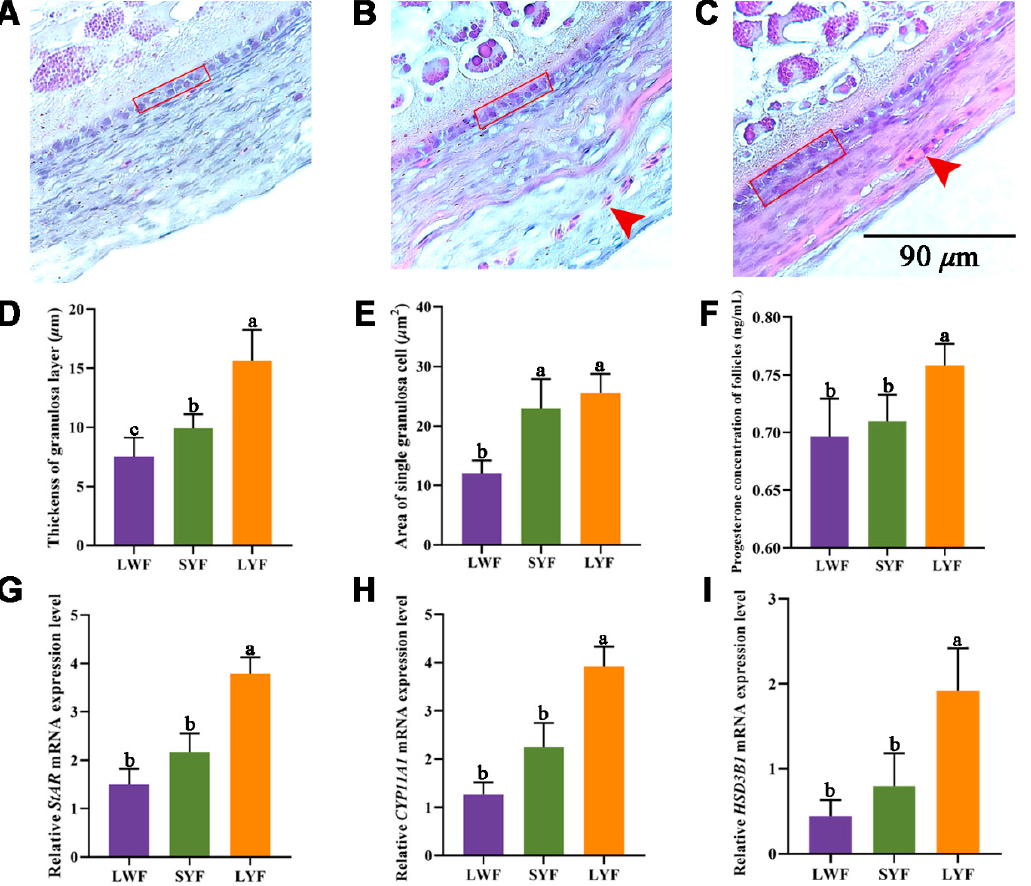
Figure 3. Histological observation and progesterone concentration of follicles. ( A – C ) Paraffin sections of large white follicles (LWF) ( A ), small yellow follicles (SYF) ( B ), and large yellow follicles (LYF) ( C ). Sections of 5 µ m thickness were cut and stained with hematoxylin and eosin. The red rectangles indicate the granulosa cell layer, and the red arrows indicate the blood vessels; scale bar = 90 µ m. ( D ) The thickness of granulosa cell layers. ( E ) The area of single granulosa cells. Indexes were calculated using ImageJ software. ( F ) Concentration of progesterone in follicles around follicle selection. ( G – I ) Relative mRNA expression of key genes involved in progesterone synthesis: StAR ( G ) CYP11A1 ( H ), and HSD3B1 ( I ). Values are as mean ± standard error ( n = 6); different letters indicate significant difference ( p < 0.05).